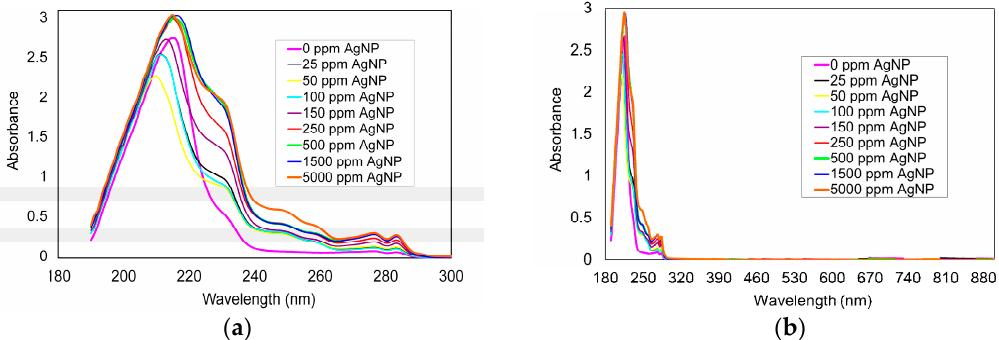
Figure 2. UV/VIS spectra of the pristine Bis-GMA/TEGDMA and its AgNP loaded modifications in the range of: ( a ) 190–300 nm; ( b ) 190–900 nm.